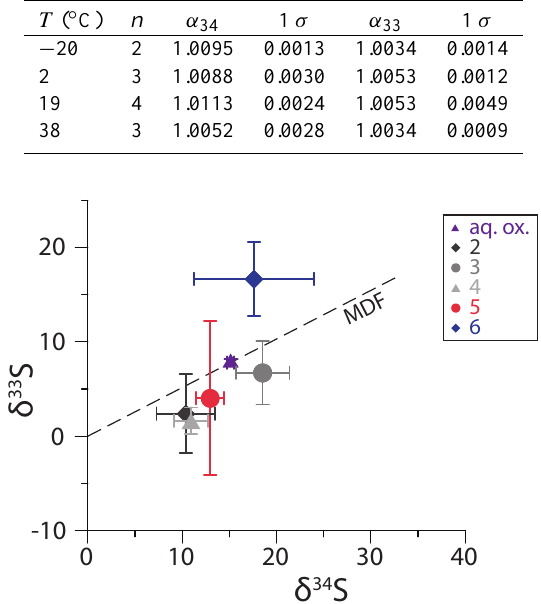
Fig. 9. Isotopic composition of interferences in the reaction of SO 2 and OH. See Fig. 2 for explanation of legend numbers. Aq. ox. shows the isotopic composition of the products of aqueous oxida- tion by H 2 O 2 or O 3 . Error bars are the 1 σ standard